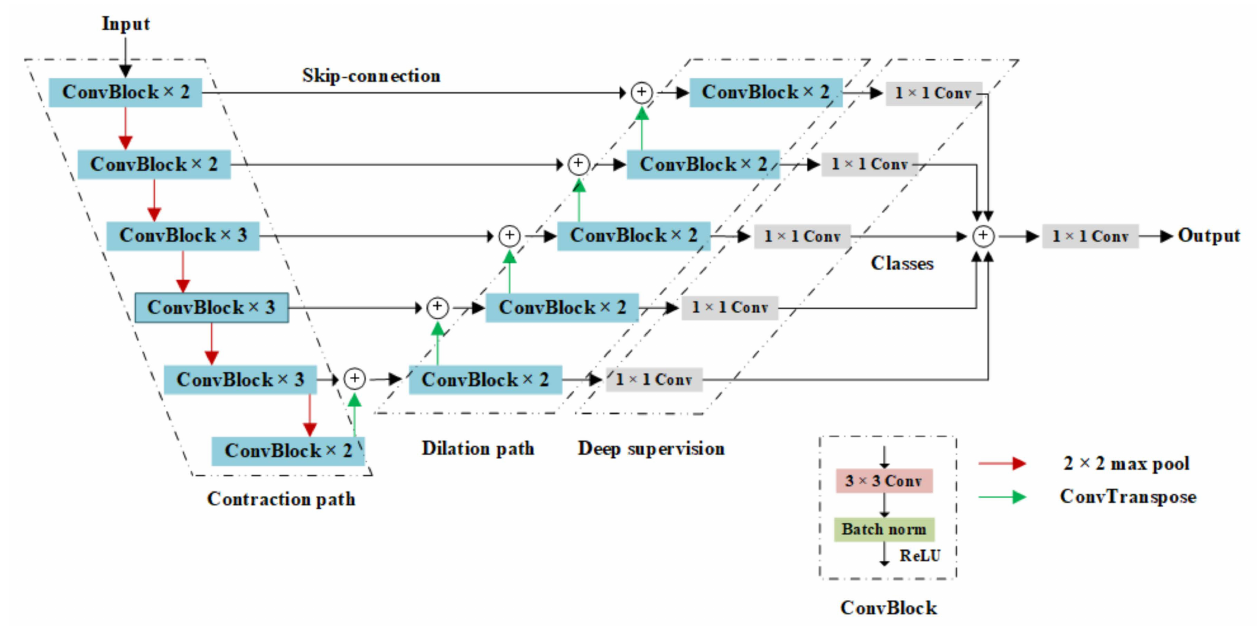
Figure 2. Model VDS-UNET proposed in this